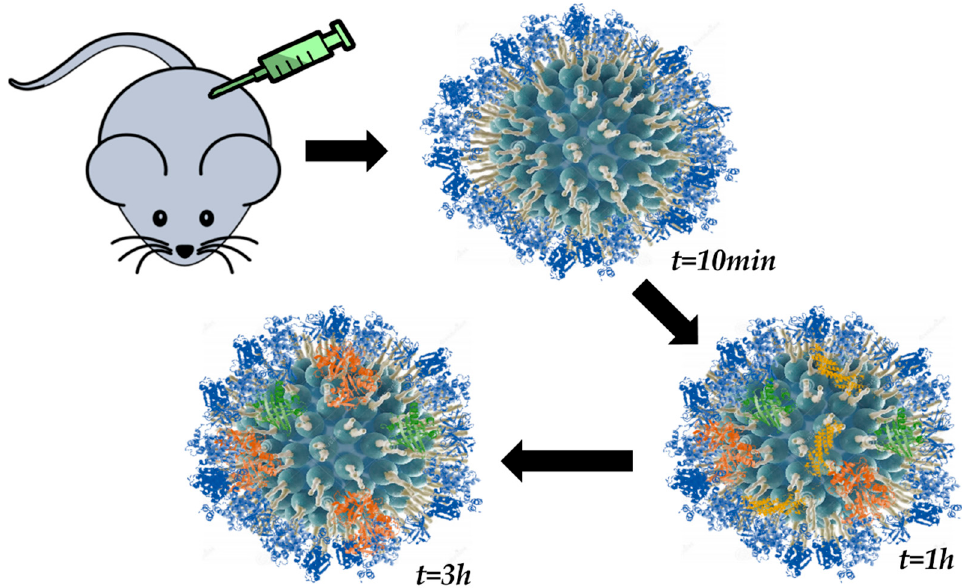
Figure 6. Schematic representation of the time-evolution study of the PC on lipid NPs performed by Hadjidemetriou et al. [74] (cross-section view).